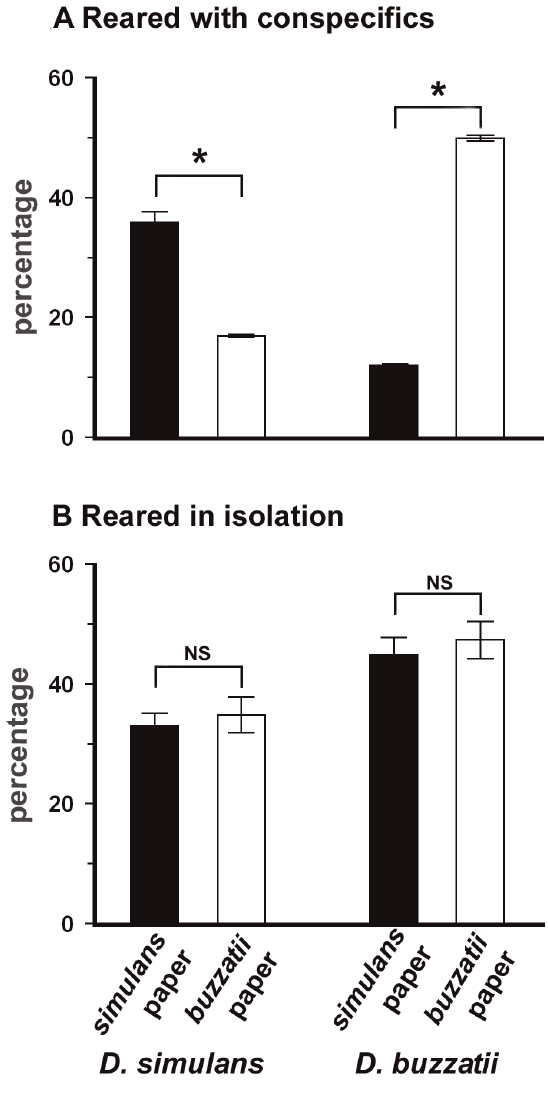
Figure 2. Time, min; mean 6 S.E., spent by third instar larvae of D. simulans and D.buzzatii on conspecific and heterospecific papers. The larvae were reared with conspecifics (Fig. 2a), and in isolation from conspecifics (Fig. 2b), and tested individually. Black columns, time spent on simulans paper; white columns time spent on buzzatii paper. *Mann-Whitney U -test; P , 0.05; NS = non significant differences (see text for details).